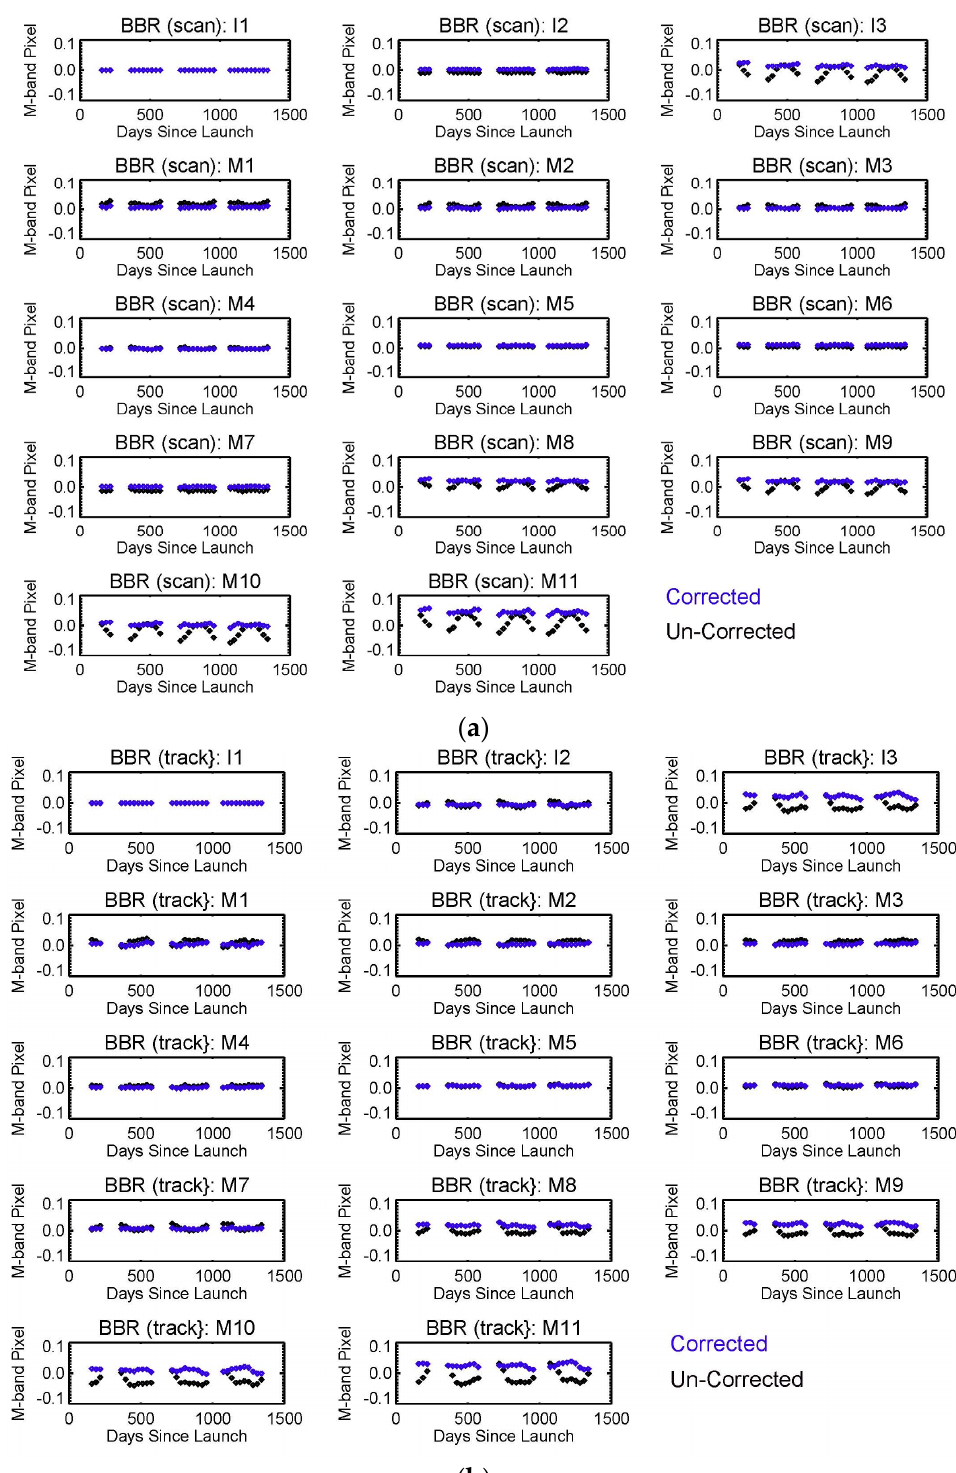
Figure 7. The image rotation-corrected VIIRS BBR results in both ( a ) along-scan and ( b ) along-track directions, referenced to Band I1.